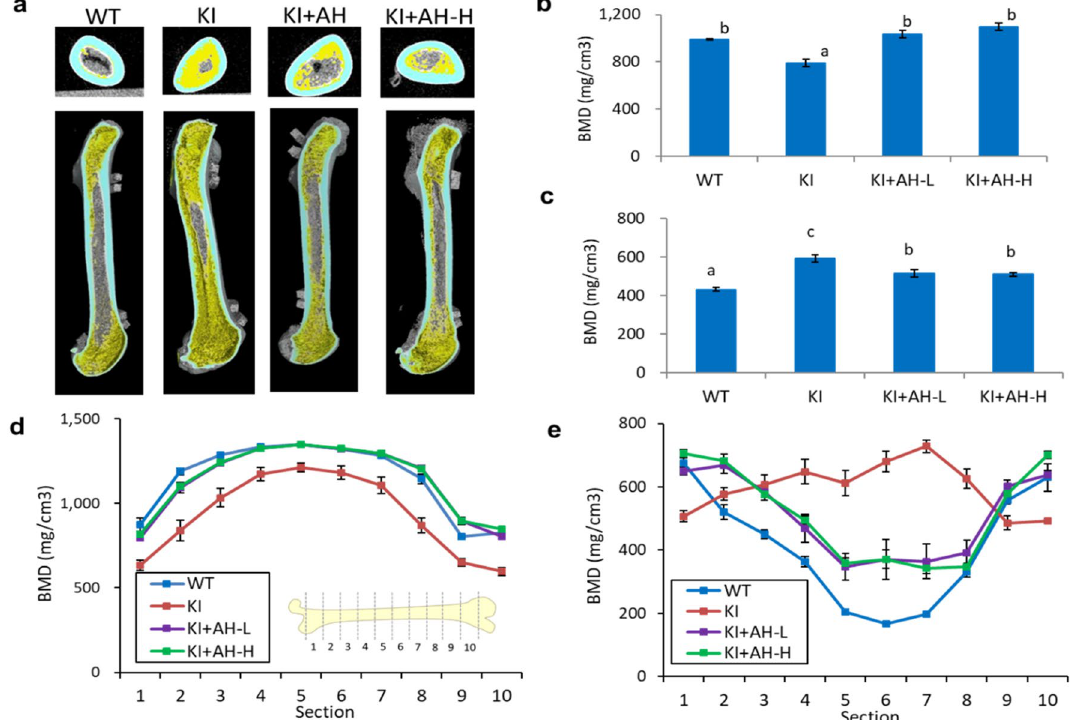
Figure 4. Impact of AH-1 on rickets bone phenotypes of Vdr(R270L) rats. ( a ) Femur structure with horizontal 2-D images at distal femur (upper panels) and vertical 3-D images of whole femur (lower panels) at 15 weeks old. Cortical and trabecular bone were colored with cyan and yellow, respectively. ( b , c ) Cortical ( b ) and trabecular ( c ) BMD of whole femur at 15 weeks old. Values of BMD are the means ± SEM (n = 5–8 animals/ group). ( d , e ) Cortical ( d ) and trabecular ( e ) BMD distribution between horizonal 10 sections of whole femur at 15 weeks old. Section 1 and 10 are the most proximal and distal section, respectively. Values of BMD are the means ± SEM (n = 5